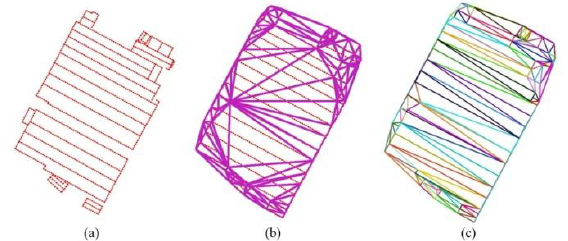
Fig. 2. Delaunay Triangulation with and without line constraints.